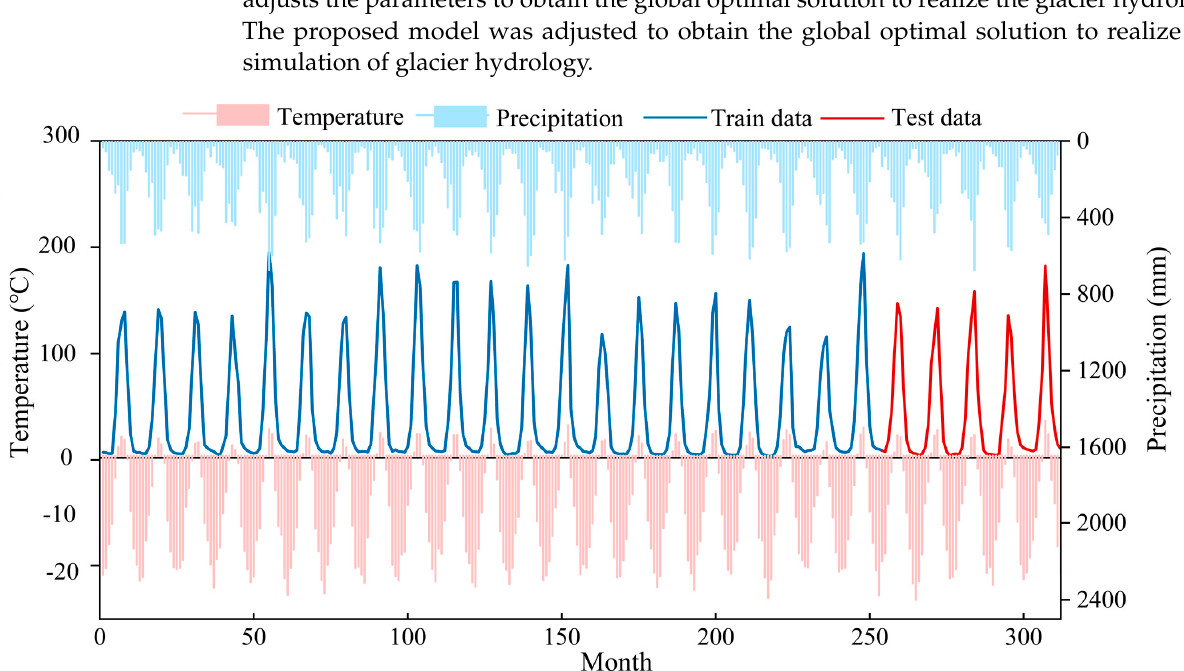
Table 1. Average monthly trends of the runoff, air temperature, and precipitation from 1990 to 2015 at Pochengzi hydrological station and its upstream watershed.